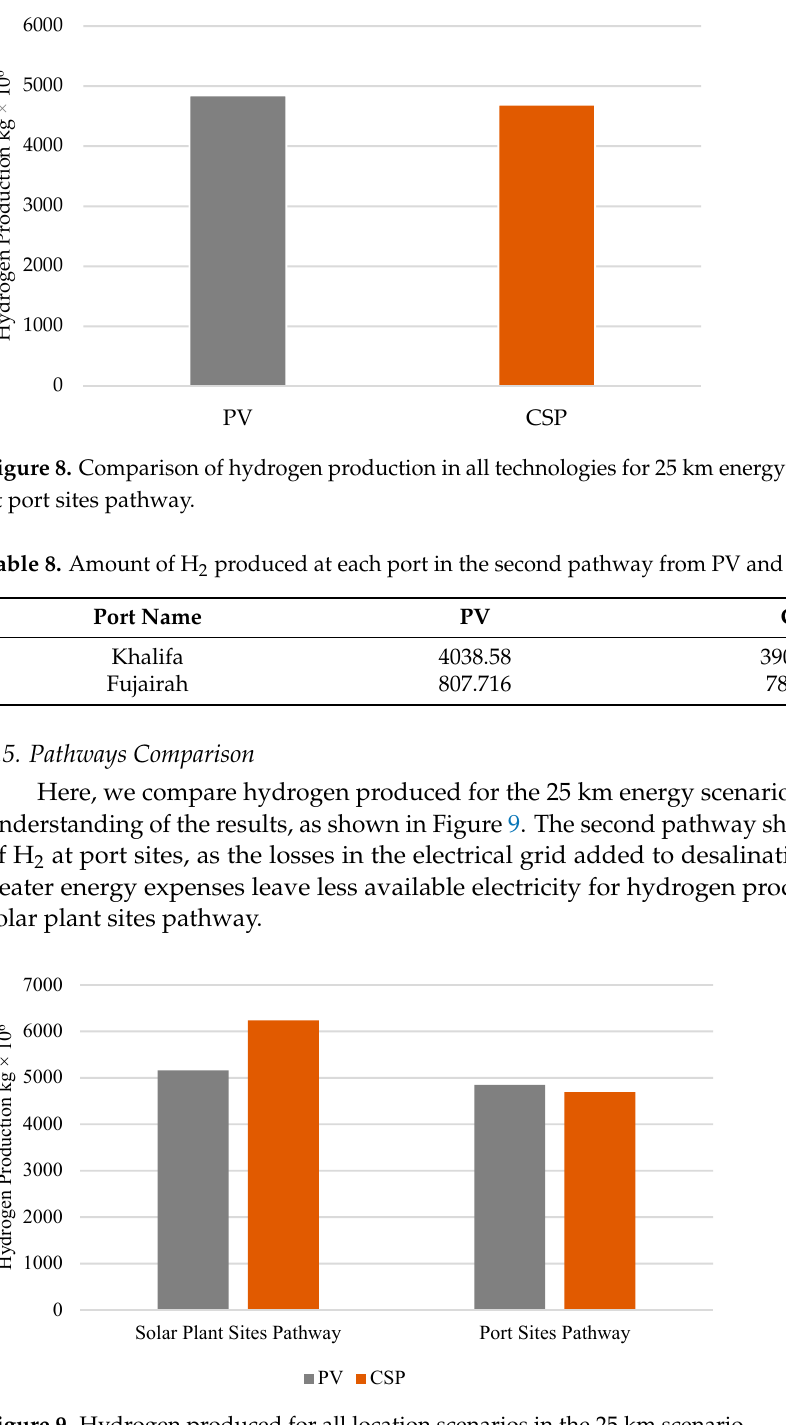
Figure 10. Proposed shortest routes from hydrogen plants to export ports analysis with GIS.